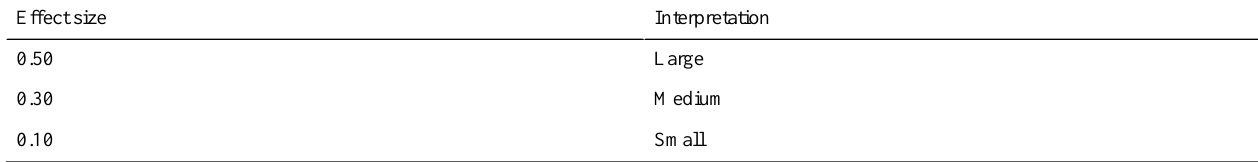
Table 3. Interpretation of Cohen d (effect